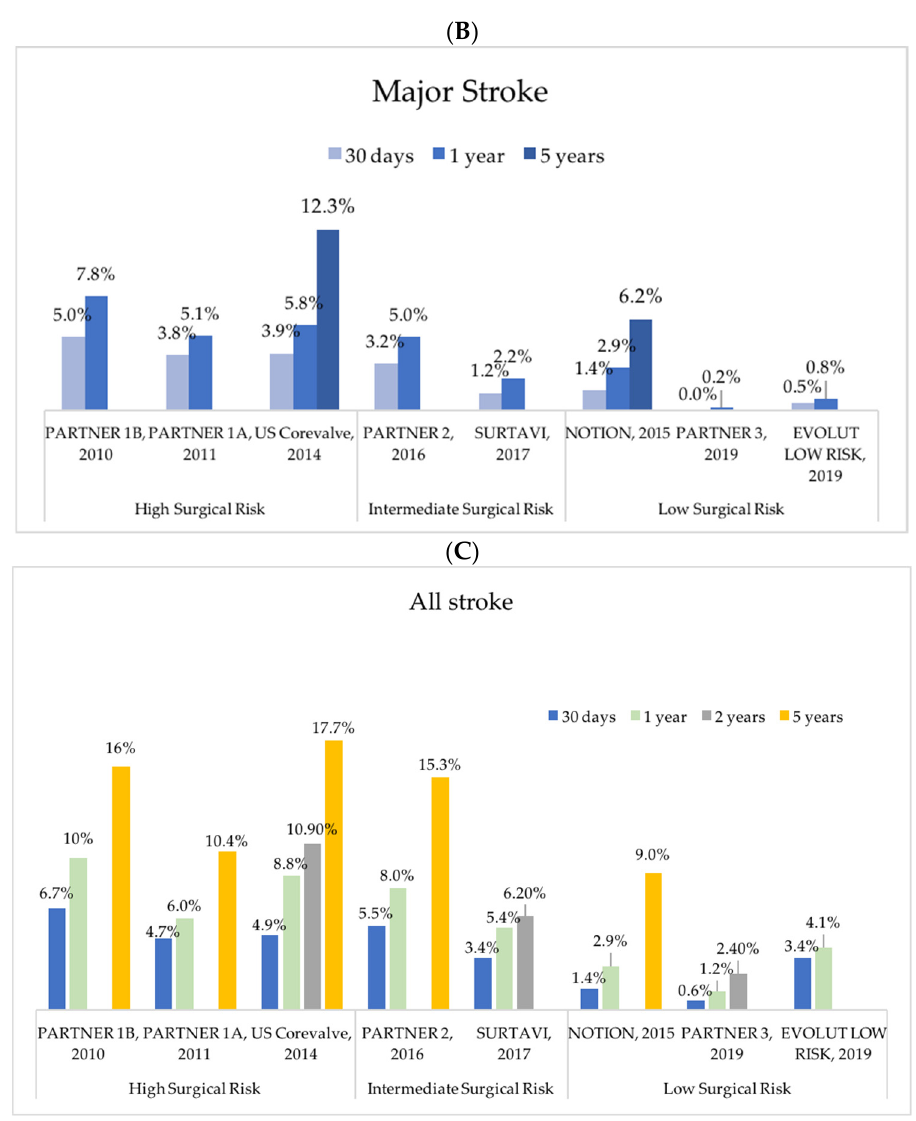
Figure 2. Reported incidences of transient ischemic attack ( A ), major stroke ( B ) and all stroke ( C ) after transcatheter aortic valve replacement in pivot trials. NOTION: Nordic Aortic Valve Intervention Trial; PARTNER: Placement of Aortic Transcatheter Valve; SURTAVI: Safety and Efficacy Study of the Medtronic Corevalve© System in the Treatment of Severe, Symptomatic Aortic Stenosis in Intermediate Risk Subjects Who Need Aortic Valve Replacement.